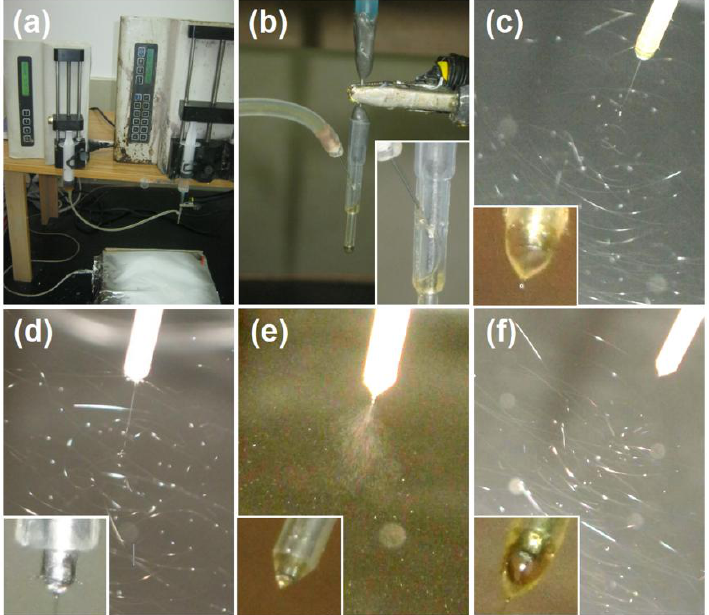
Figure 3. Implementations of EHDA processes for fabricating samples F1 and F2: ( a ) a whole digital image of the customized electrospinning apparatus; ( b ) the connection of spinneret with the working fluid (the down-right inset shows an enlarged image) and power supply; ( c ) the preparation of core–sheath nanofiber F1 (the down-left inset shows a typical Taylor cone); ( d ) a single-fluid electrospinning of the core working fluid, which had fine electrospinnability (the down-left inset shows a typical Taylor cone); ( e ) a single-fluid electrospraying of the sheath working fluid, which was not electrospinnable (the down-left inset shows a typical Taylor cone); and ( f ) the preparation of the down layer of sample 2 (the down-left inset shows a typical compound Taylor